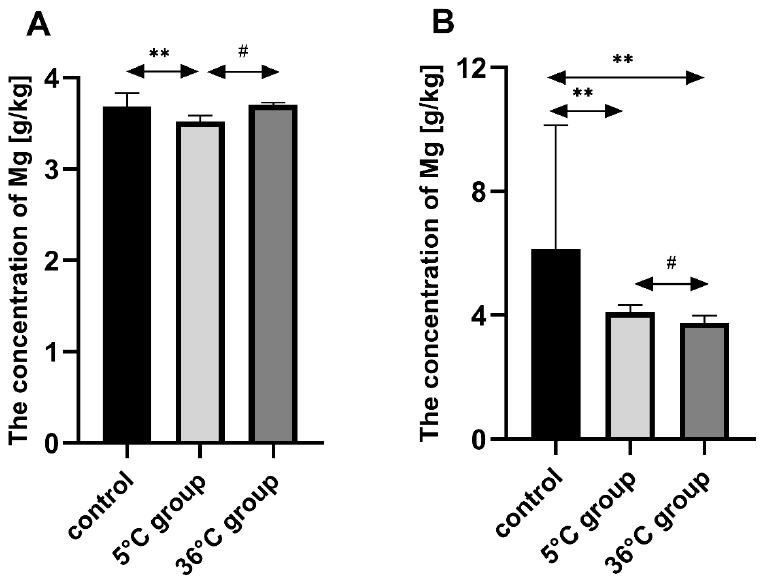
Figure 2. Bone Mg [g/kg] in female ( A ) and male ( B ) rats from the control group and the test groups. Rats were subjected to 4 min swimming sessions for 9 weeks in either cold water at 5 ◦ C or at a thermally comfortable temperature of 36 ◦ C. The first swimming session was 2 min long (day one) increasing by 0.5 min per day to 4 min (day five of the first week). Results are presented as means and standard deviations. ** p < 0.005 level of statistical significance vs. the 5 ◦ C group (Mann–Whitney U test). # p < 0.05 level of statistical significance vs. the 5 ◦ C group (Mann–Whitney U test).